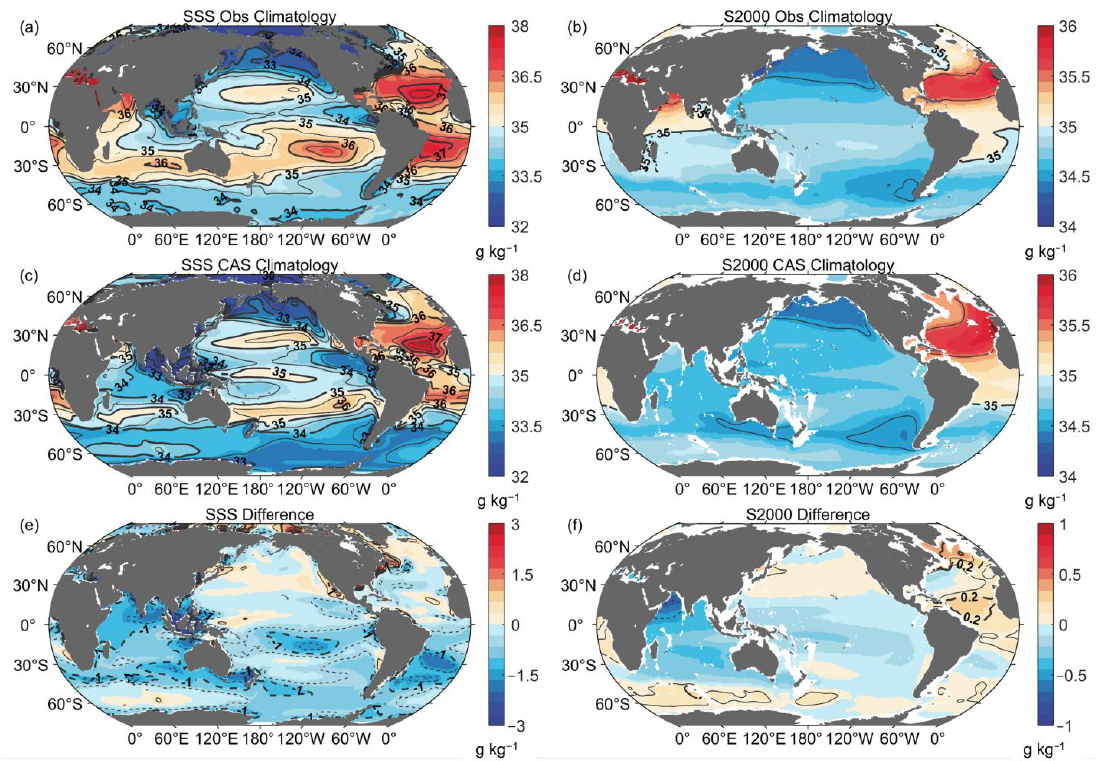
Figure 1. Global climatology of ( a ) the sea surface salinity (SSS) and ( b ) 0–2000 m averaged salinity (S2000) for the ensemble means of the four observational products, ( c , d ) for the CAS-ESM2-0 model. The difference between the model and observational mean is shown in ( e , f ), respectively.